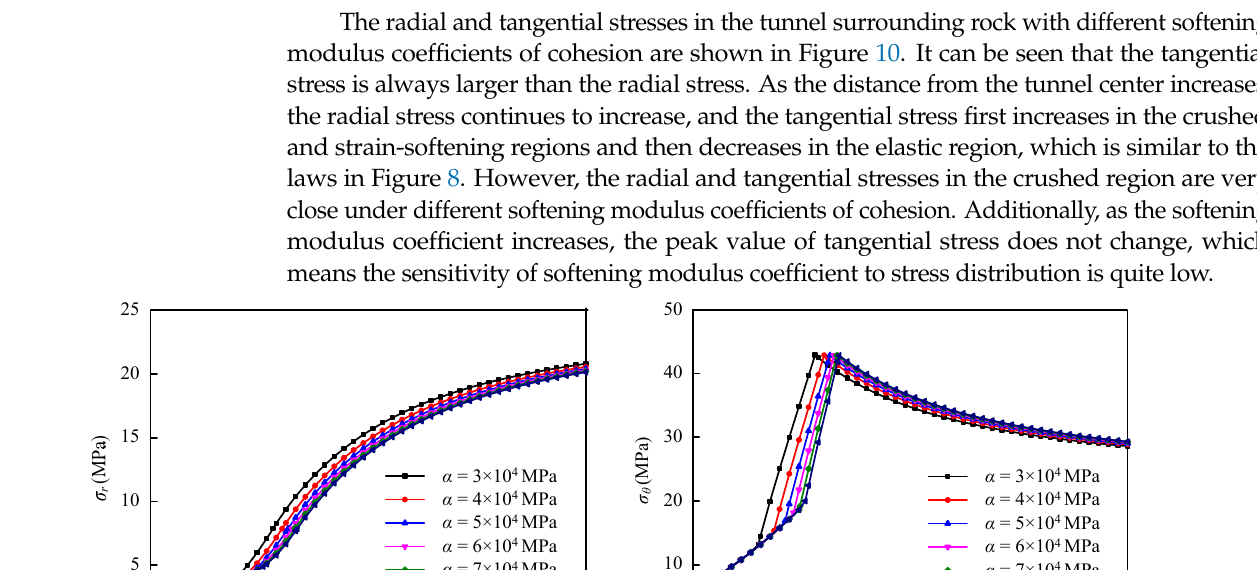
Figure 9. Effect of softening modulus coefficient of cohesion on the radii of strain-softening and crushed regions and surface displacement. ( a ) R s and R c ; ( b ) u 0 .